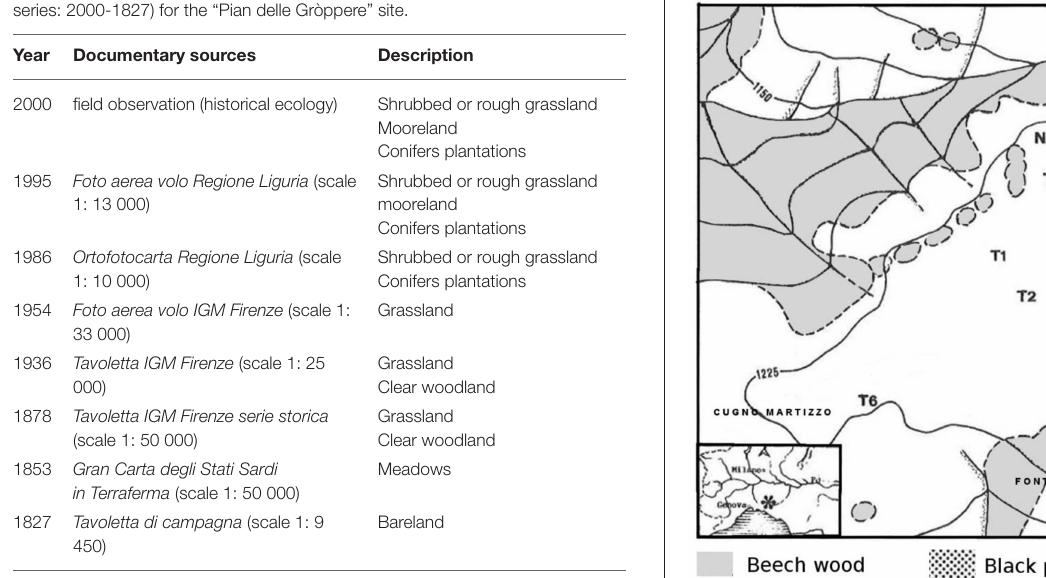
stones has a sandy-silty granulometry and dark brown colour: it contains many charcoals (1